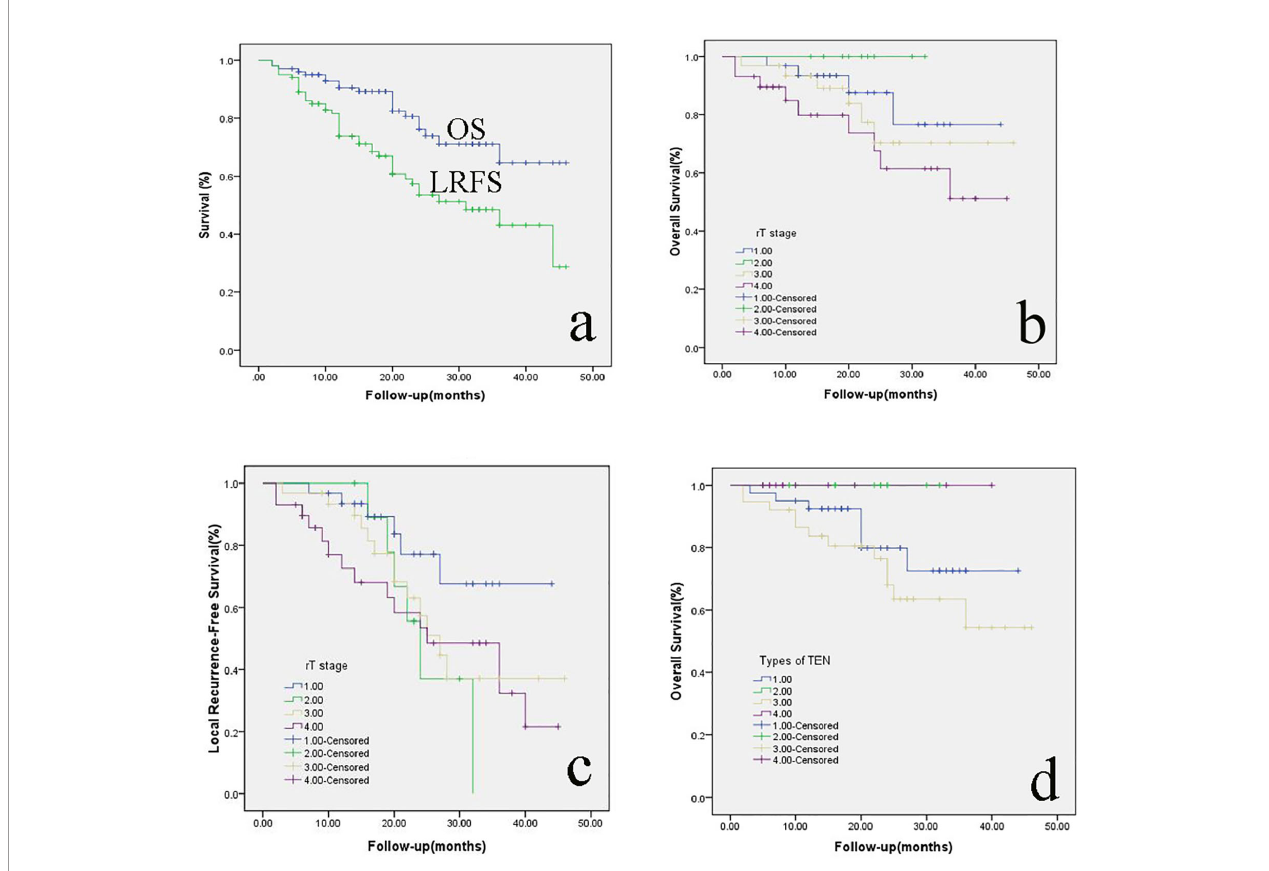
FIGURE 5 | (A) the 2-year OS and LRFS of rNPC patients; the 2-year OS (B) and LRFS (C) of rNPC with different T stages; (D) : the 2-year OS of rNPC with different types of TEN. OS, overall survival; LRFS, Local recurrence-free survival; rNPC, recurrent nasopharyngeal carcinoma; TEN, transnasal endoscopic